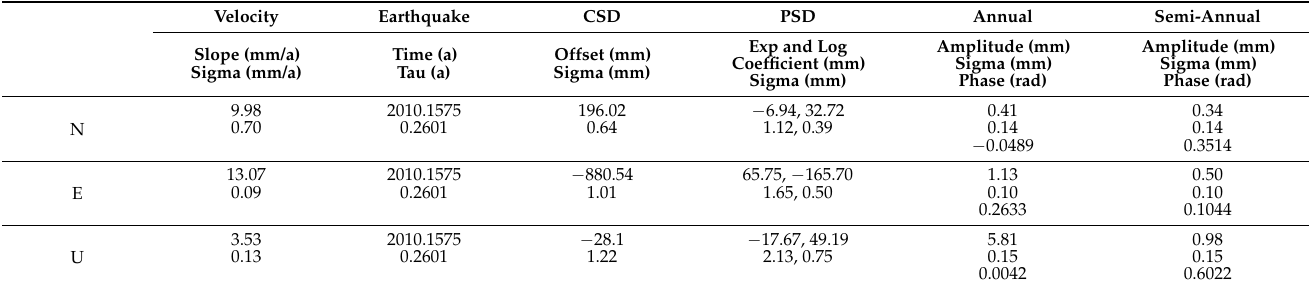
Table 4. Parameter fitting result of ANTC’s time series using ITSM.